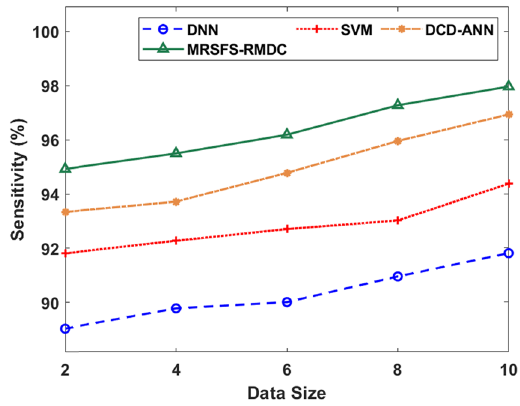
Figure 3: Sensitivity analysis of MRSFS - RMDC model with distinct data size.